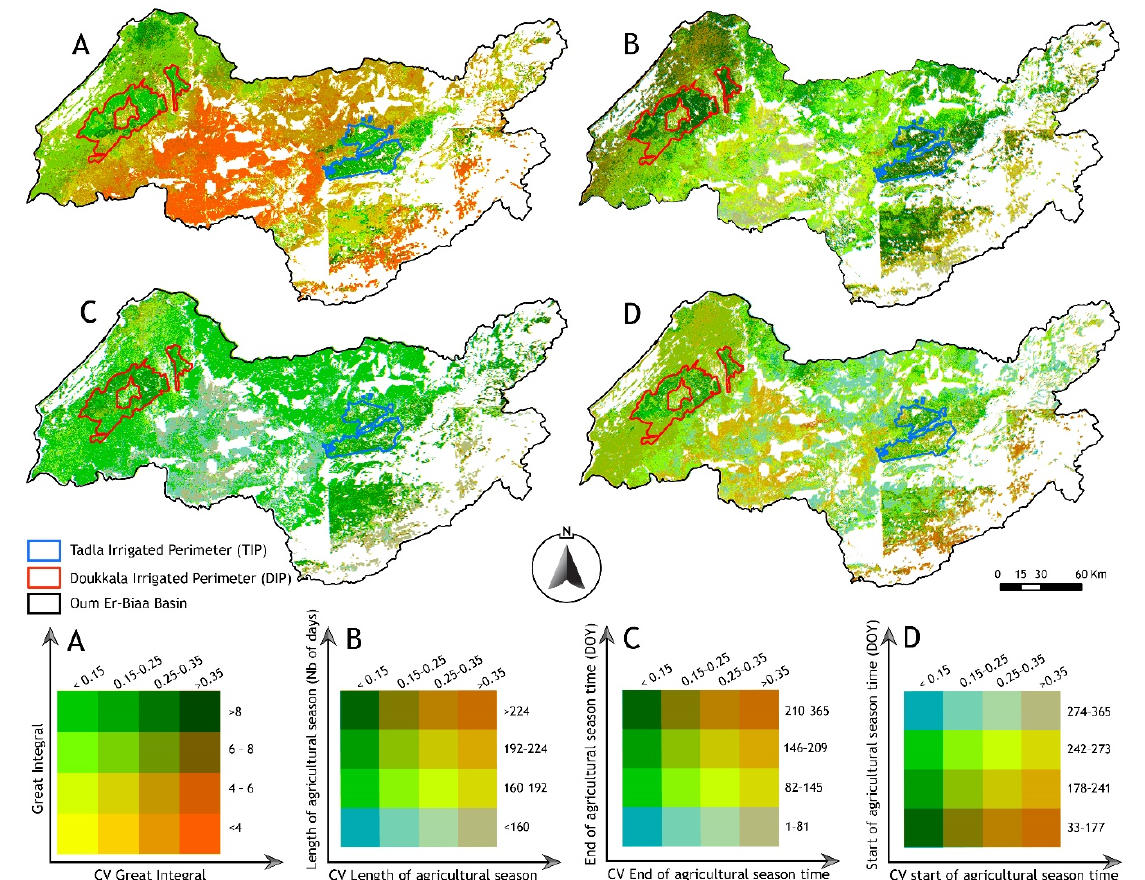
Figure 6. Bivariate maps showing, simultaneously, the great integral ( A ), length ( B ), end ( C ), and the start ( D ) of season and their coefficients of variation. High-resolution corresponding figures are provided with the Supplementary Materials.